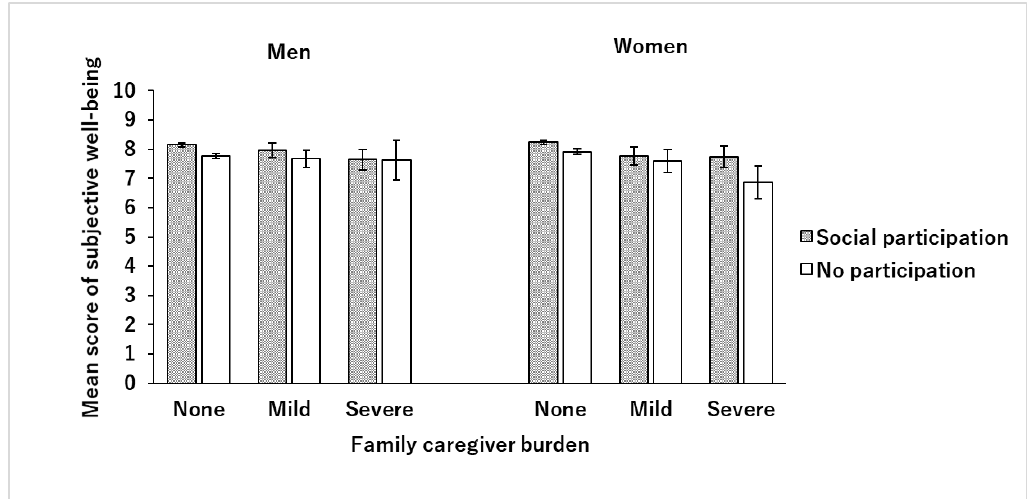
Figure 1. Mean scores of subjective well-being stratified by social participation of family caregivers. The bars in the figure show the mean subjective well-being scores, and the error bars show 95% confidence intervals. Gray bars indicate the scores of those with social participation, and white bars indicate the scores of those without social participation. The figure demonstrates that the higher caregiver burden, the lower the subjective well-being score, in both men and women. In male participants, the trend was almost the same regardless of social participation, while in female participants, in contrast with those with social participation, those with no participation had significantly lower subjective well-being scores when caregiver burden increased.